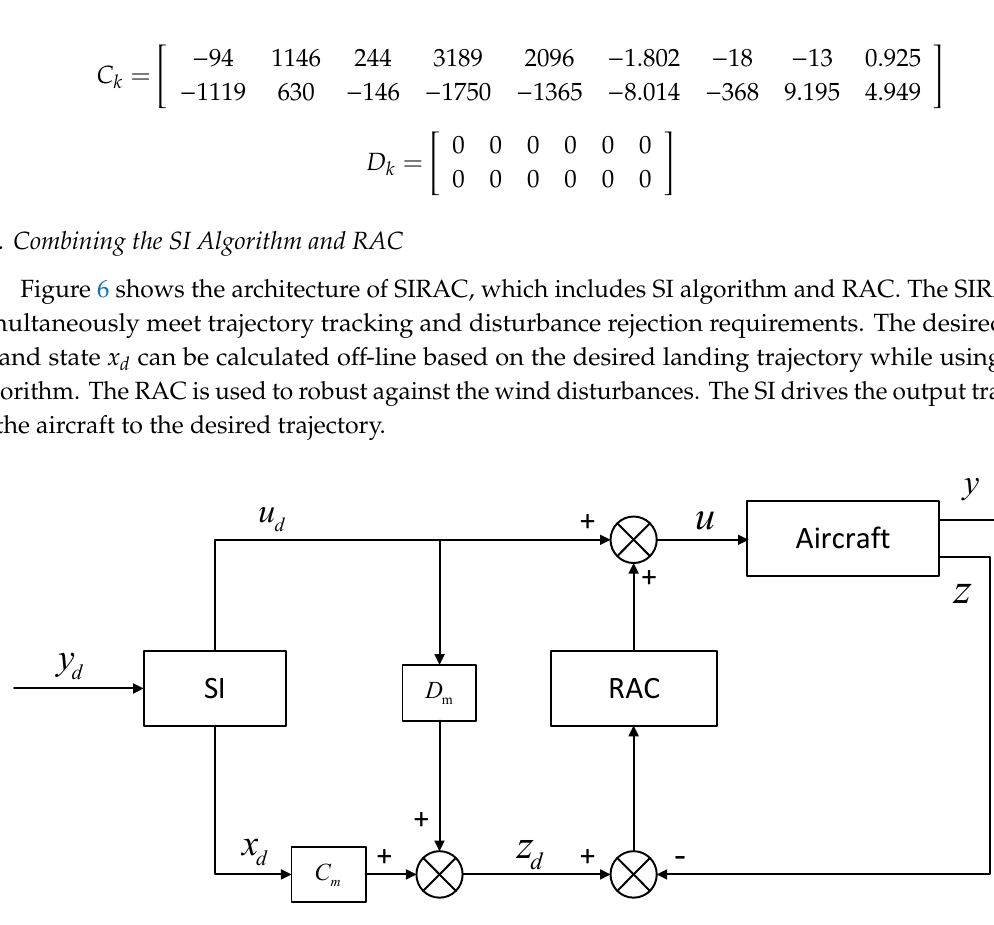
Figure 6. The stable inversion (SI) based robust autolanding controller (SIRAC) architecture. Now, the algorithm of the SIRAC is designed, as